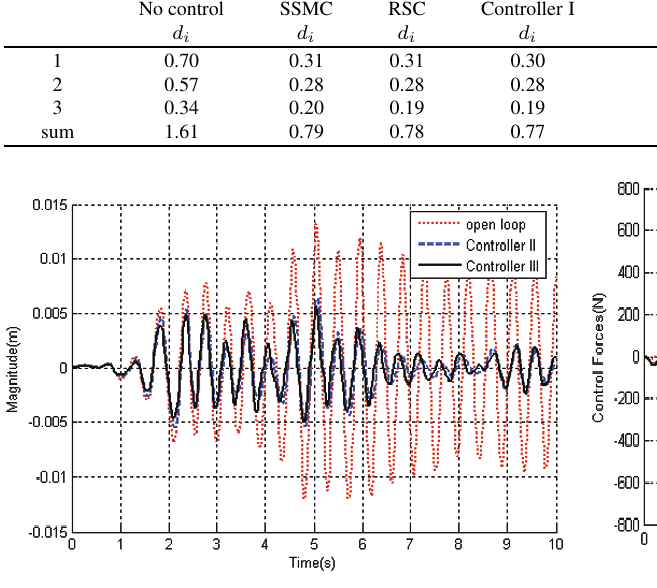
Fig. 2. The displacements of the fist floor ( θ 1 i = 0 ,θ 2 i = 0 , τ = 25 ms).